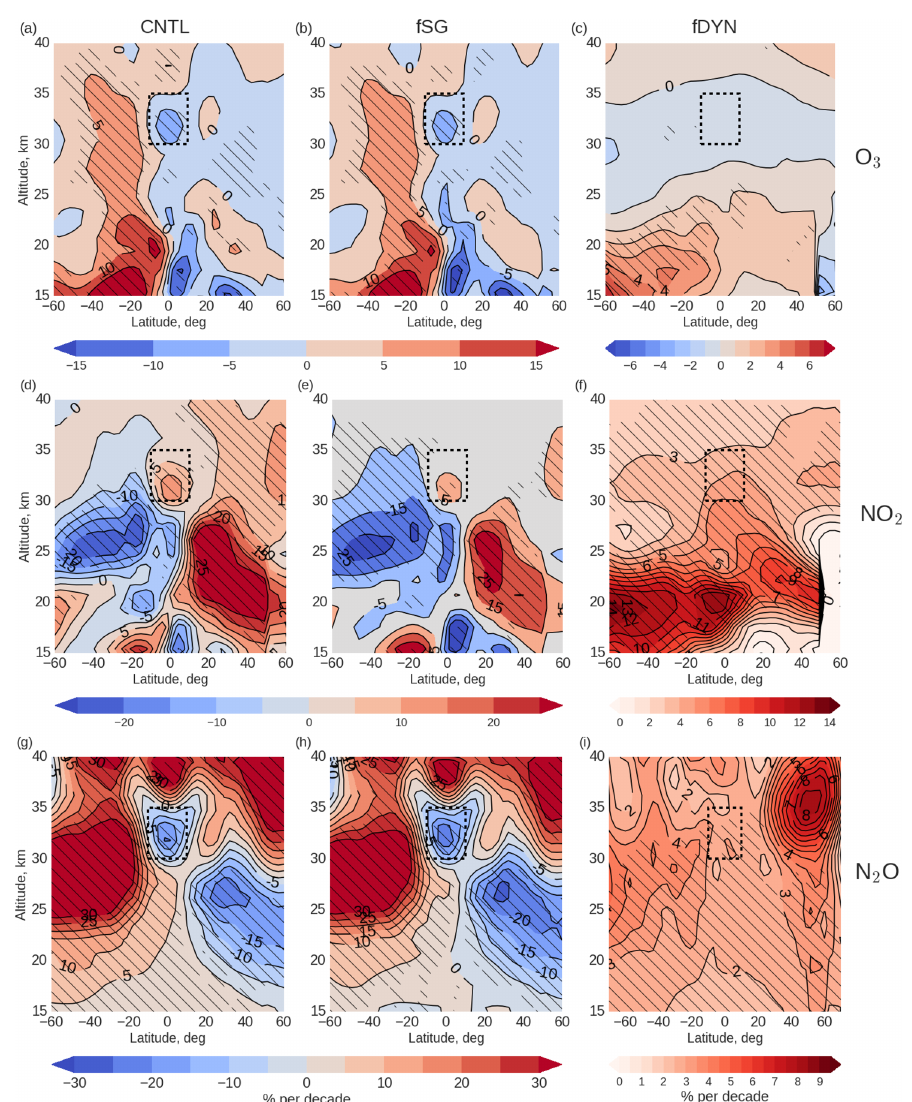
Figure 3. Latitude–altitude distribution of (a–c) O 3 , (d–f) NO 2 , and (g–i) N 2 O changes (%decade − 1 ) from the MLR model applied to TOMCAT runs in the January 2004–April 2012 period: CNTL (a, d, g) , fSG (b, e, h) , and fDYN (c, f, i) . Latitude ranges from 60 ◦ S to 60 ◦ N, and altitude ranges from 15 to 40km. Hatched areas show changes significant at the 2 σ level. The dashed rectangle indicates the region of interest in this